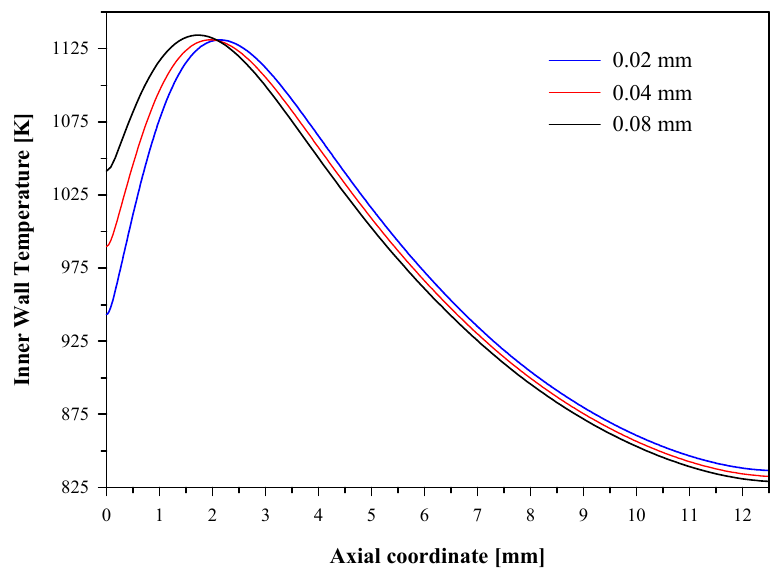
Figure 2. Axial profiles of temperature along the center line of the inner wall at different grid resolutions: V in = 0.5 m/s; All Cordierite.